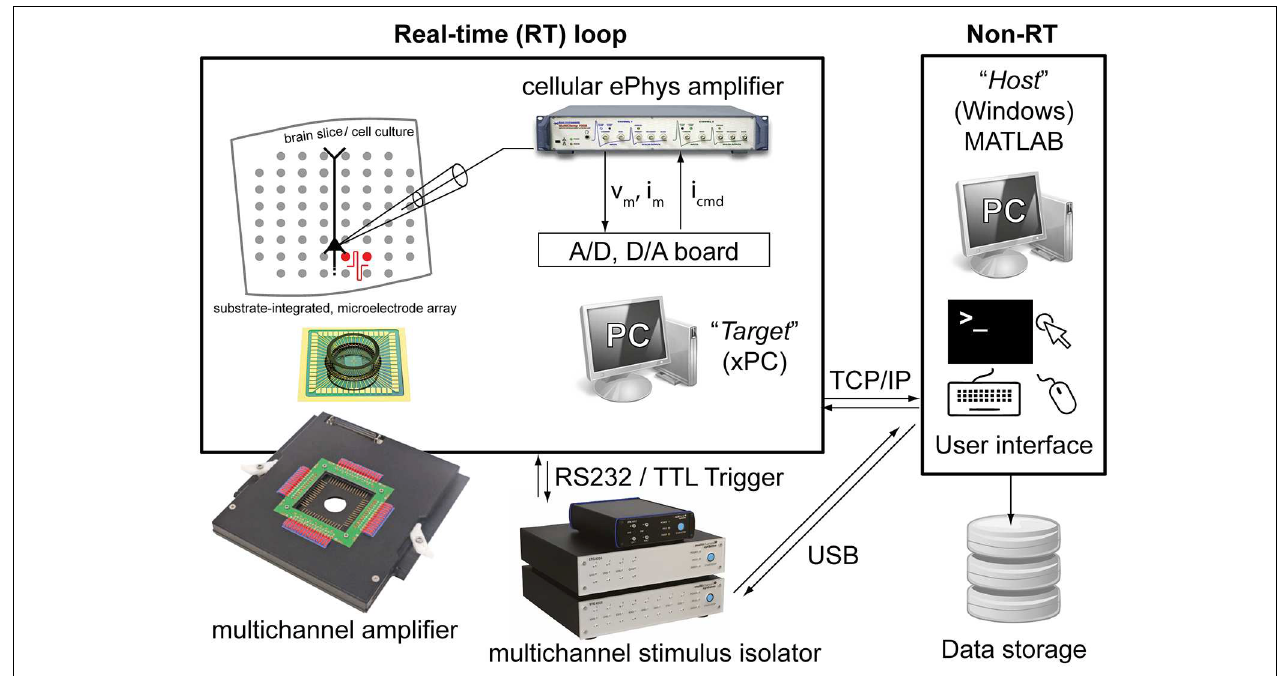
storage and control, the target operates independently and in real-time and it is programmed remotely by the host. The target is also equipped with a standard data acquisition board and with a serial port, connected to a patch-clamp amplifier and/or an extracellular stimulus